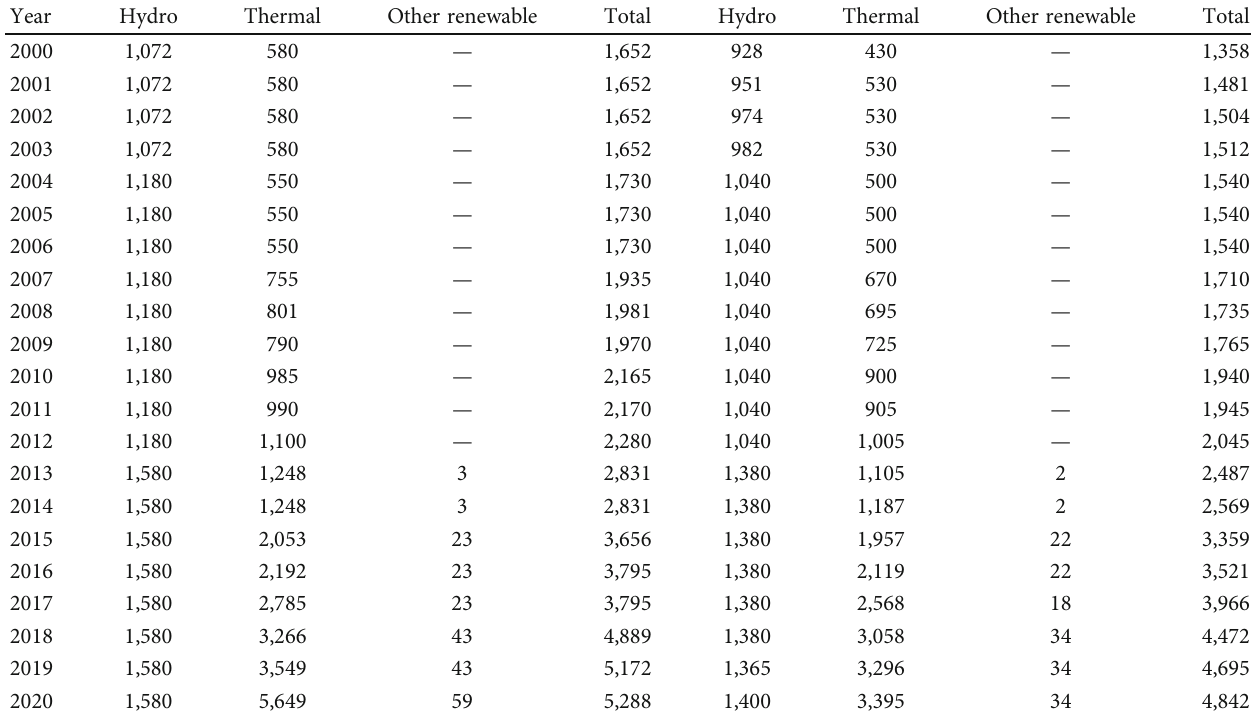
Table 2: Installed and dependable capacity (MW)